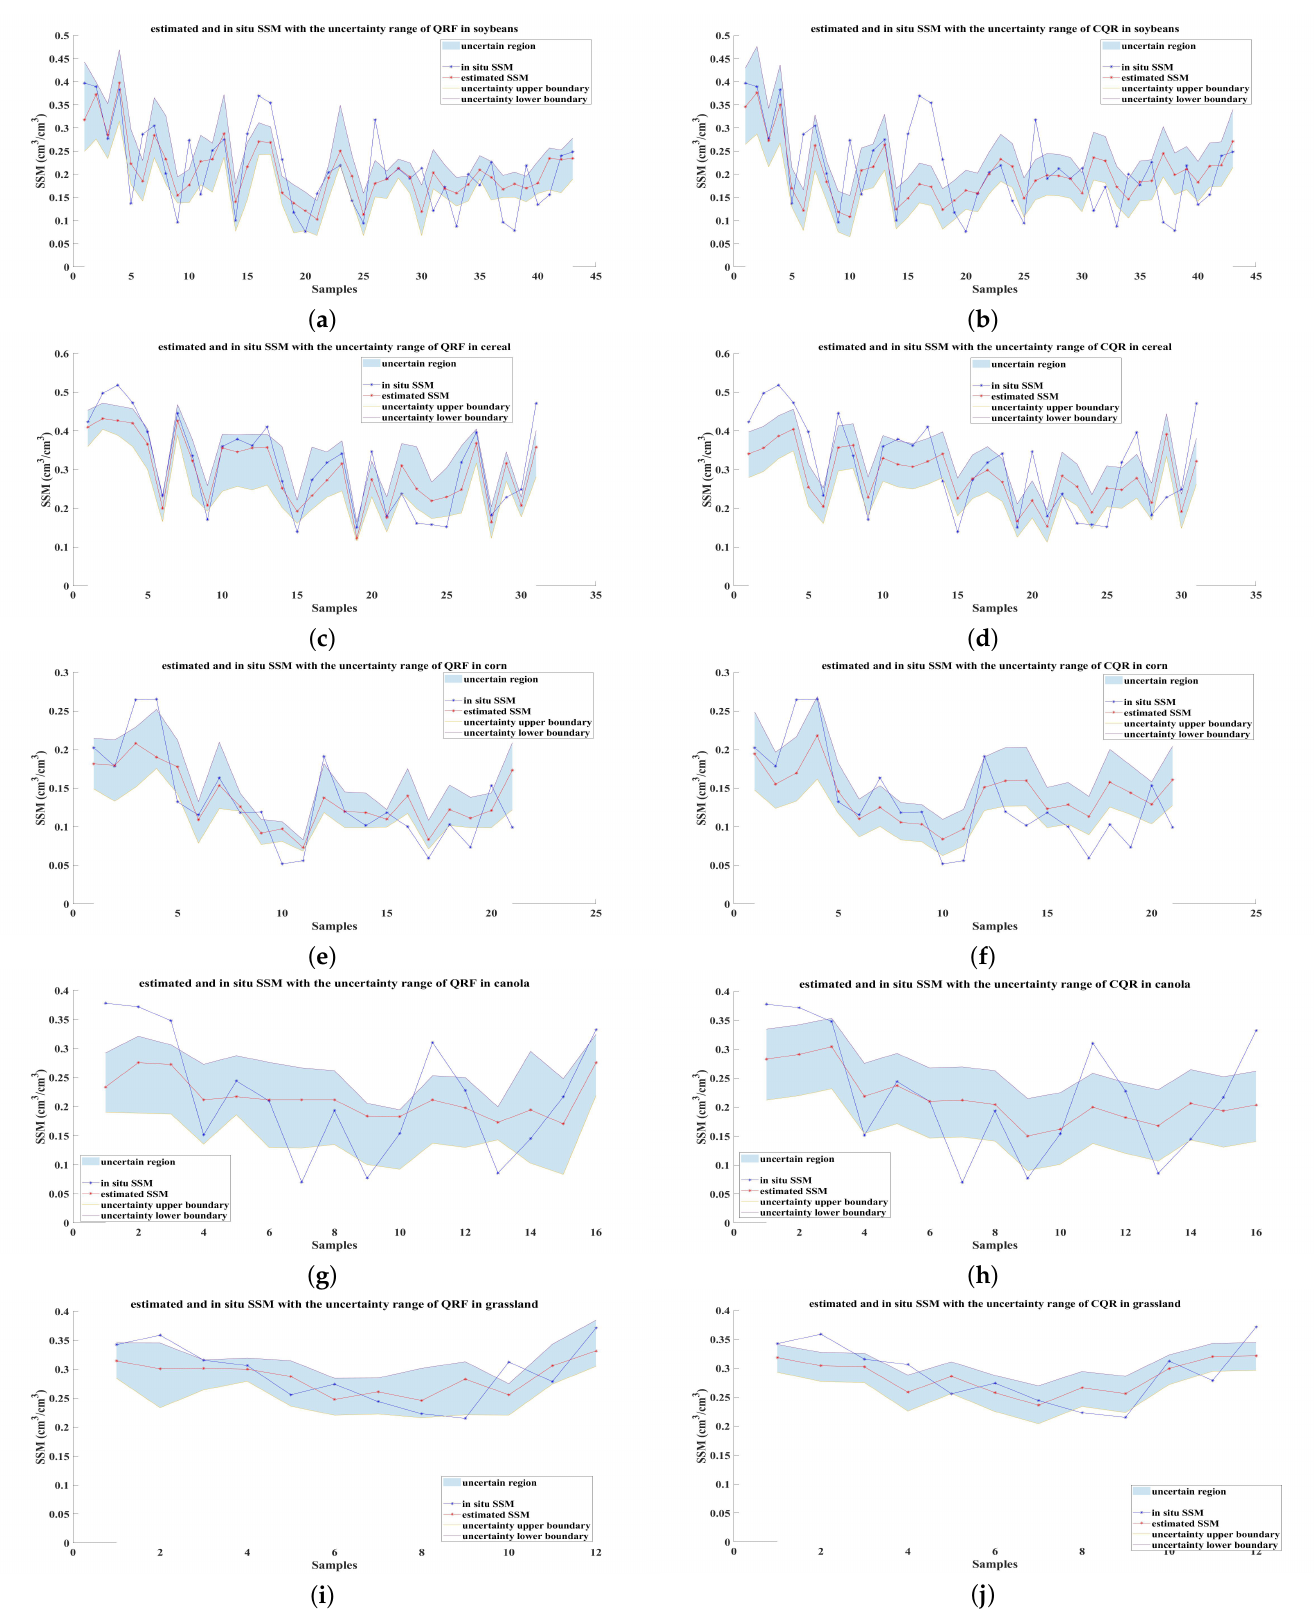
Figure 6. Estimated and in situ SSM with the uncertainty intervals. ( a ) uncertainty intervals of QRF in soybeans; ( b ) uncertainty intervals of CQR in soybeans; ( c ) uncertainty intervals of QRF in cereal; ( d ) uncertainty intervals of CQR in cereal; ( e ) uncertainty intervals of QRF in corn; ( f ) uncertainty intervals of CQR in corn; ( g ) uncertainty intervals of QRF in canola; ( h ) uncertainty intervals of CQR in canola; ( i ) uncertainty intervals of QRF in grassland; ( j ) uncertainty intervals of CQR in